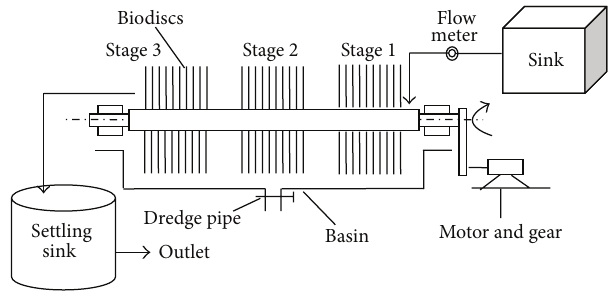
Figure 1: RBC treatment